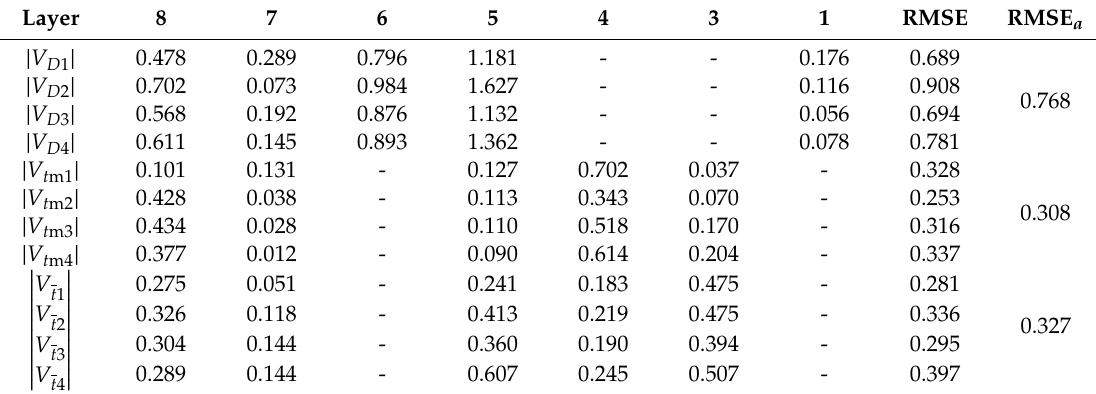
Table 6. Measurement errors of diameters and thicknesses in four experiments. (unit: mm).